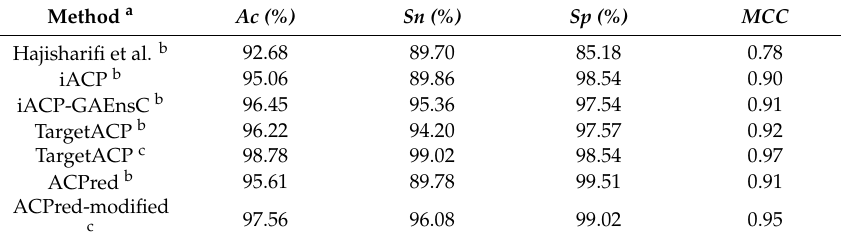
Table 4. Performance comparison of the proposed ACPred model with existing